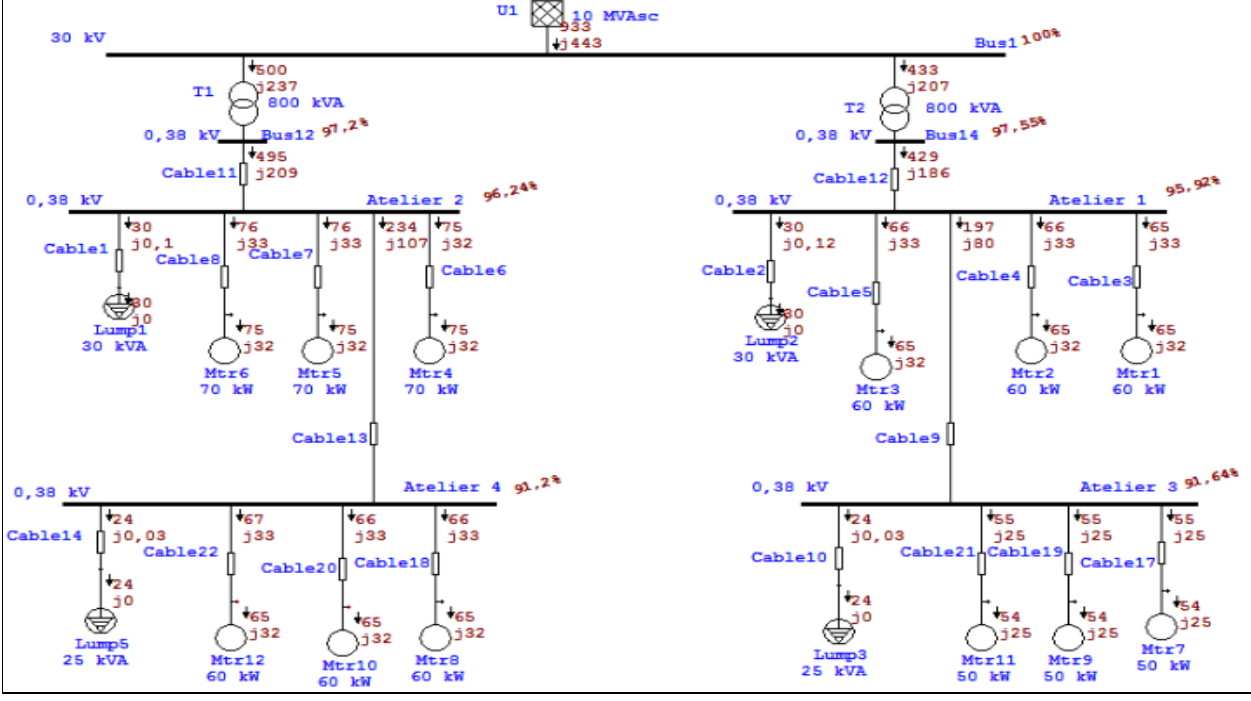
Figure 2: Power flow results. Source: Authors, (2020).